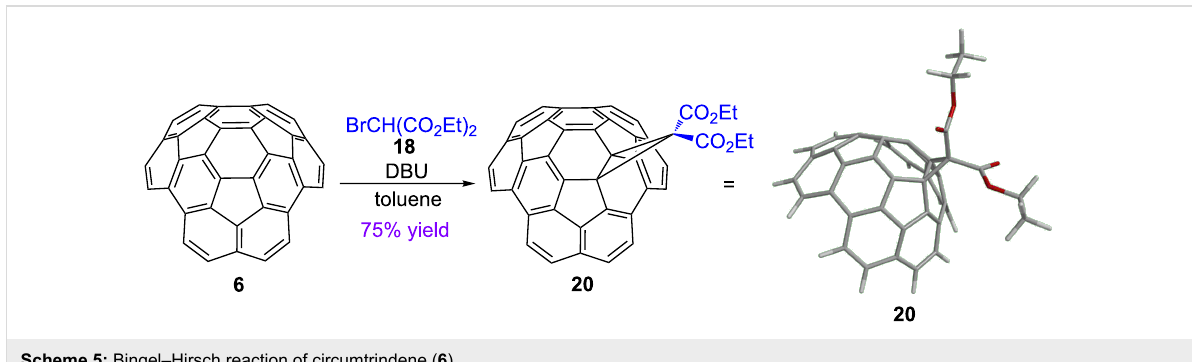
Scheme 5: Bingel–Hirsch reaction of circumtrindene ( 6 ).